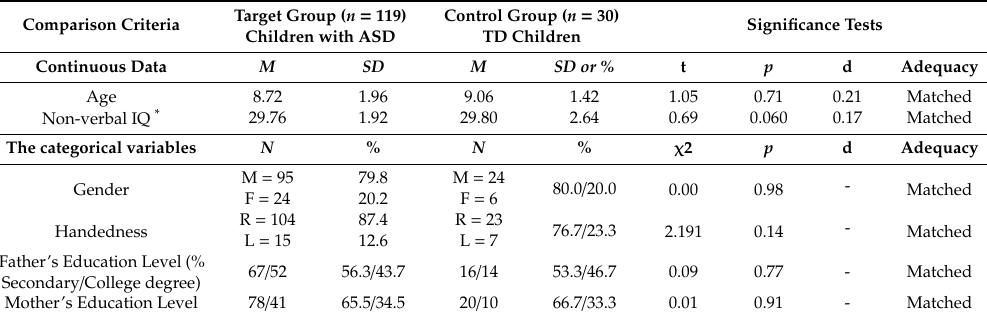
Table 1. Participants’ Demographic Characteristics and Descriptive data for the group comparisons. Comparison